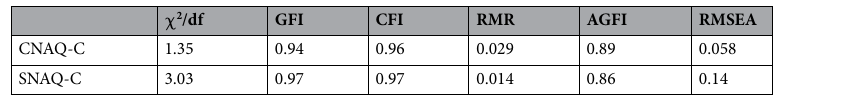
Table 2. Comparison of values for fitting to the structural equation model. RMR root of the mean square residual, CFI comparative fit index, GFI goodness of fit index, AGFI adjusted goodness of fit index, RMSEA root mean square error of approximation, CNAQ-C Council on Nutrition Appetite Questionnaire- Chinese version, SNAQ-C simplified Nutrition Appetite Questionnaire- Chinese version.